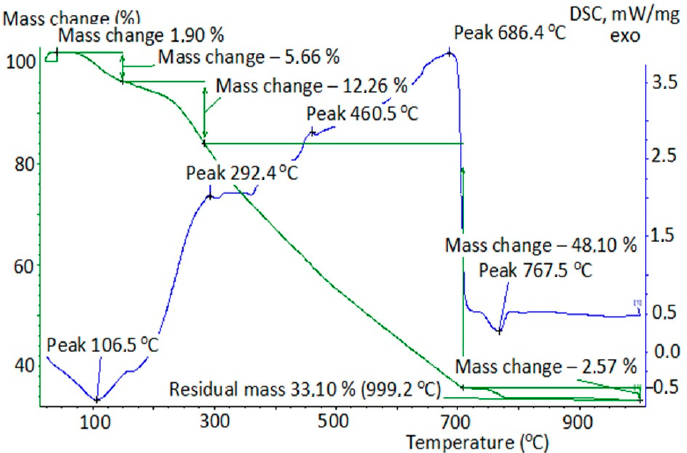
Figure 2. Thermogram of iron-containing peat composite after the sorption of oxalic acid. Environments 2018 , 5 , x FOR PEER REVIEW